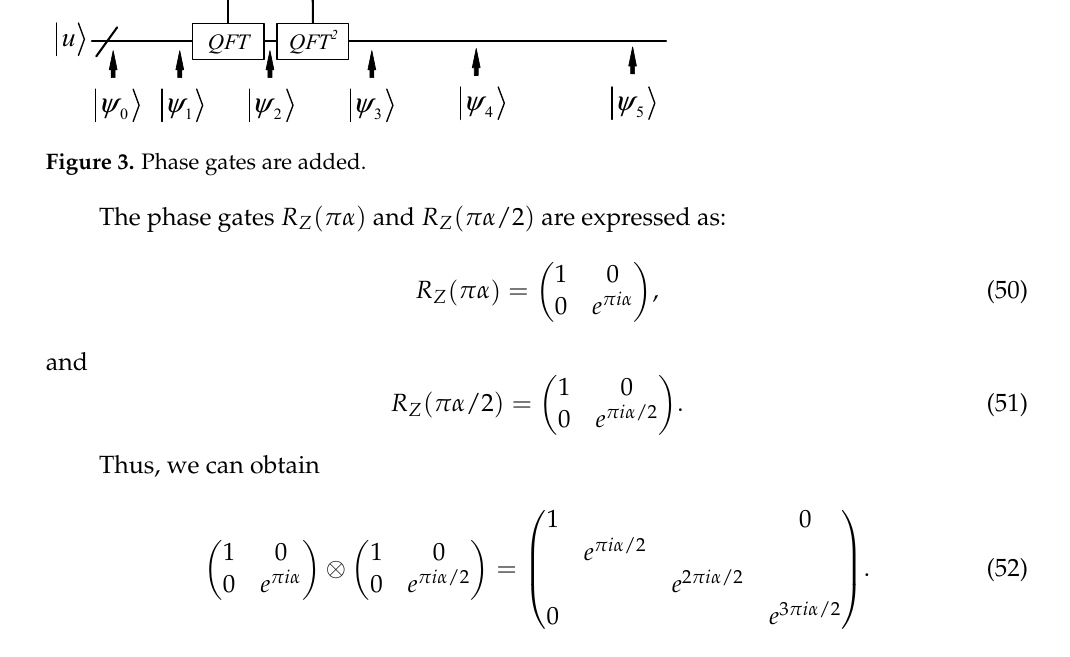
Figure 3. Phase gates are added.